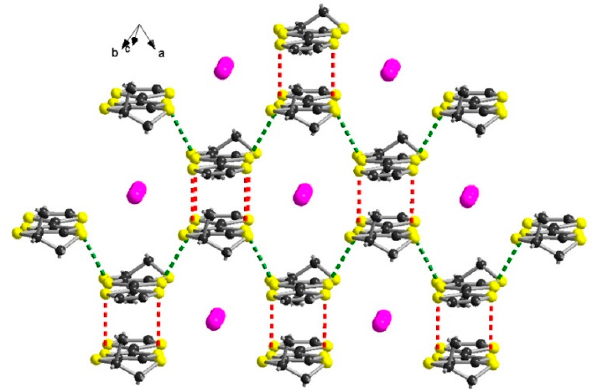
Figure 7. Packing of donors in the structure of [( R )- 1 ]I 3 with emphasis on the S···S contacts shorter than 3.6 Å: red dotted lines for 3.33, 3.35 and 3.39 Å; green dotted lines for 3.45 and 3.48 Å.